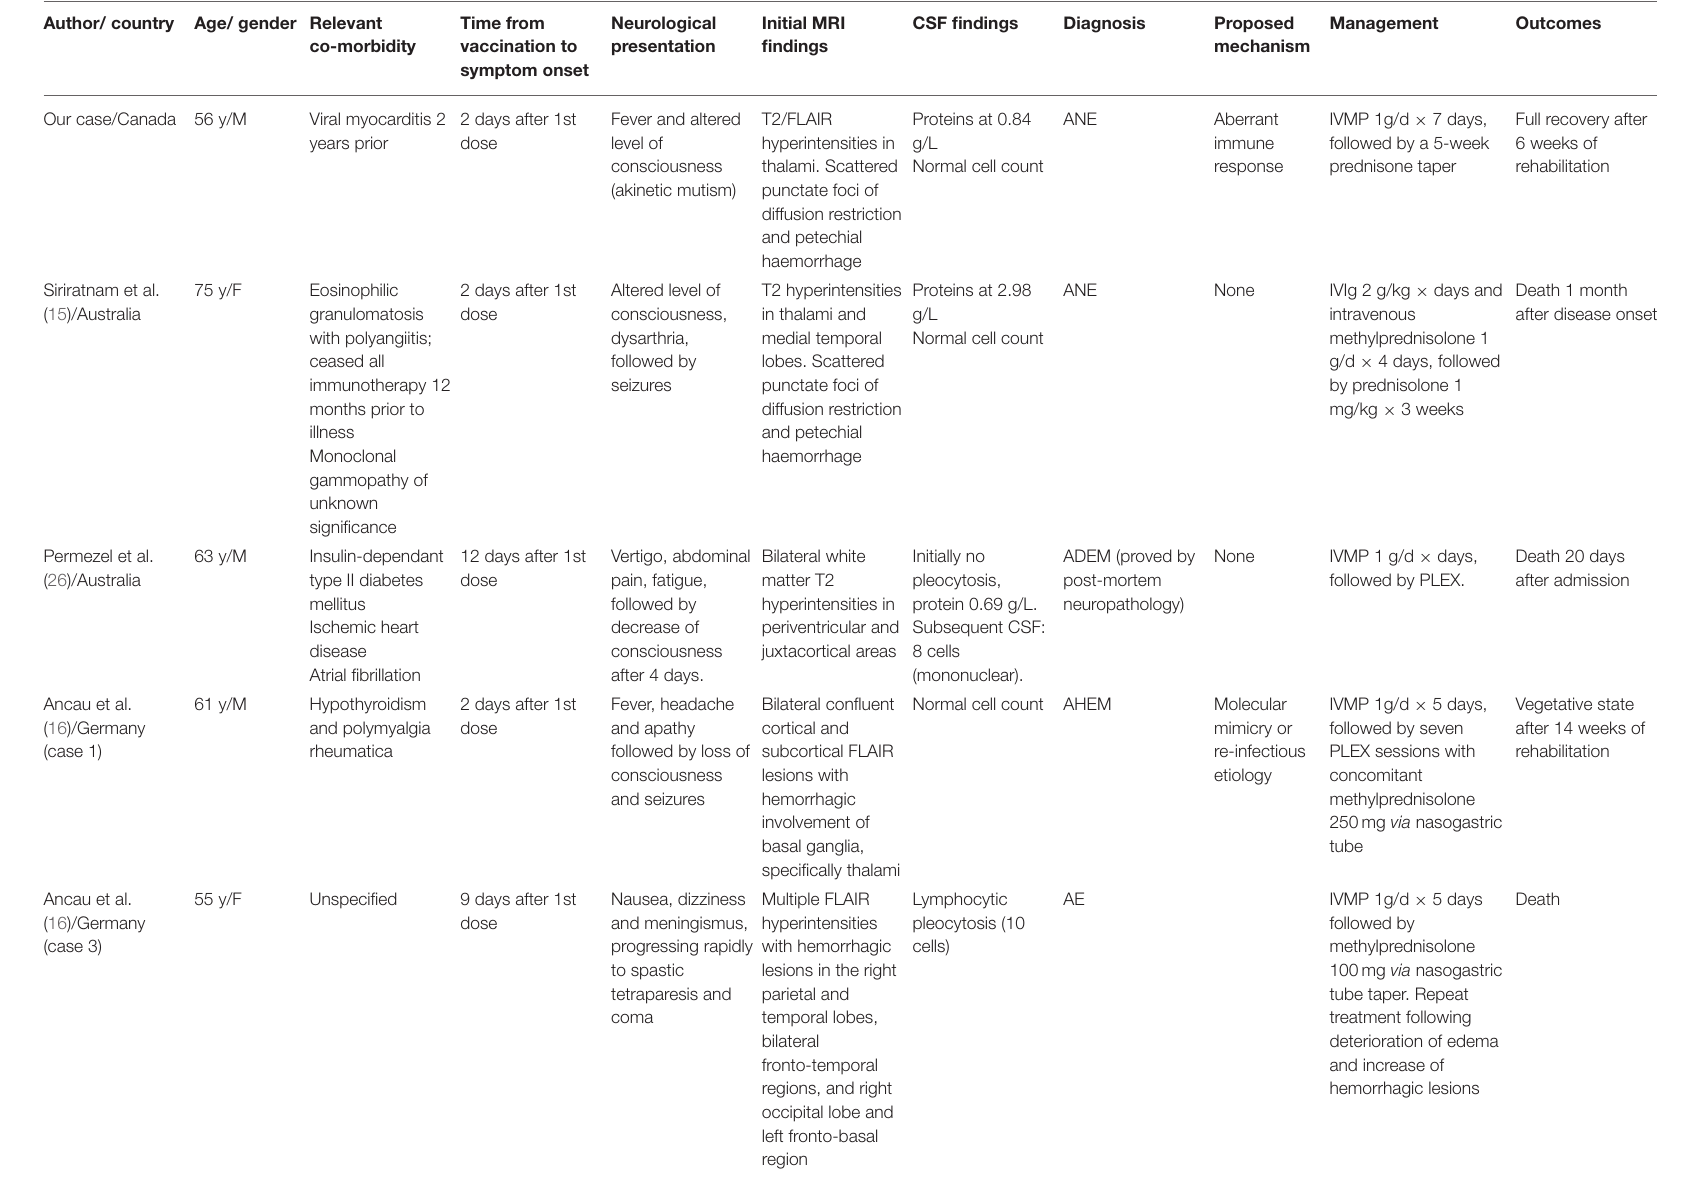
TABLE 2 | Cases presenting with altered level of consciousness following ChAdOx1 nCoV-19